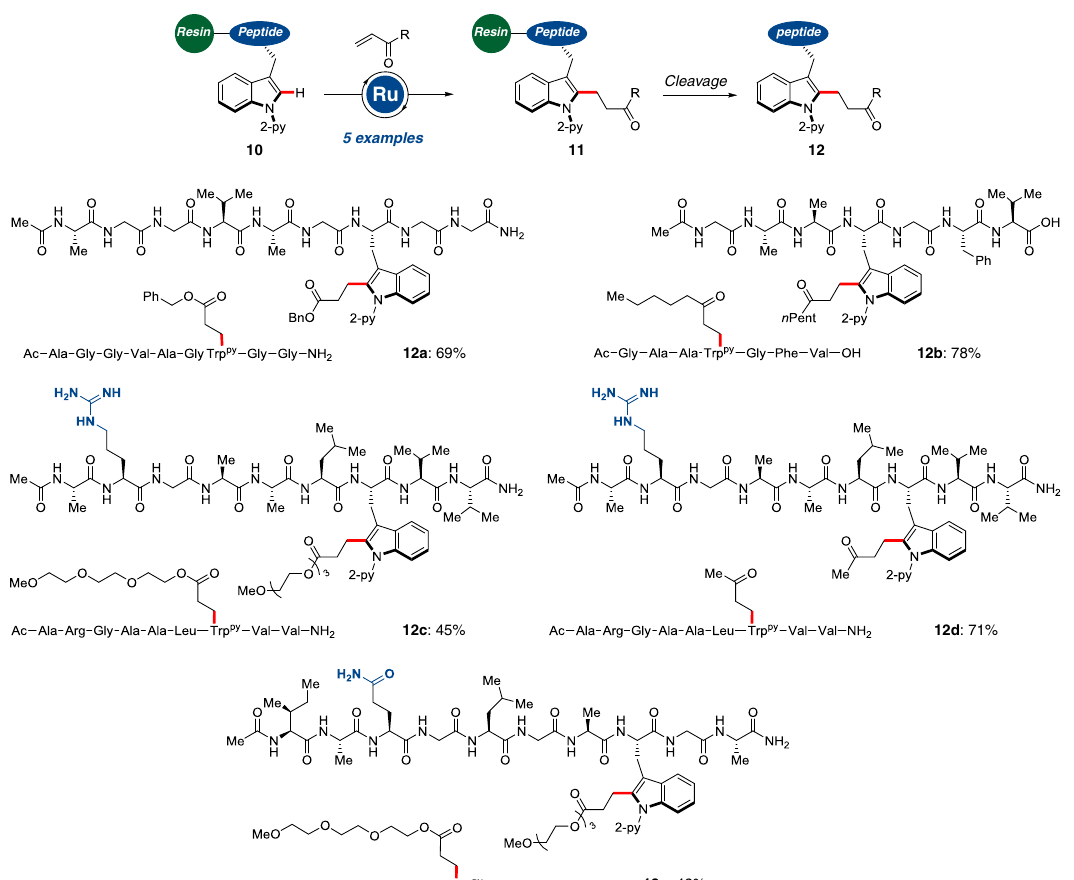
Fig. 7 C – H functionalization on solid support. On-resin C – H alkylation by user-friendly solid phase peptide synthesis providing access to diversely decorated nona- and